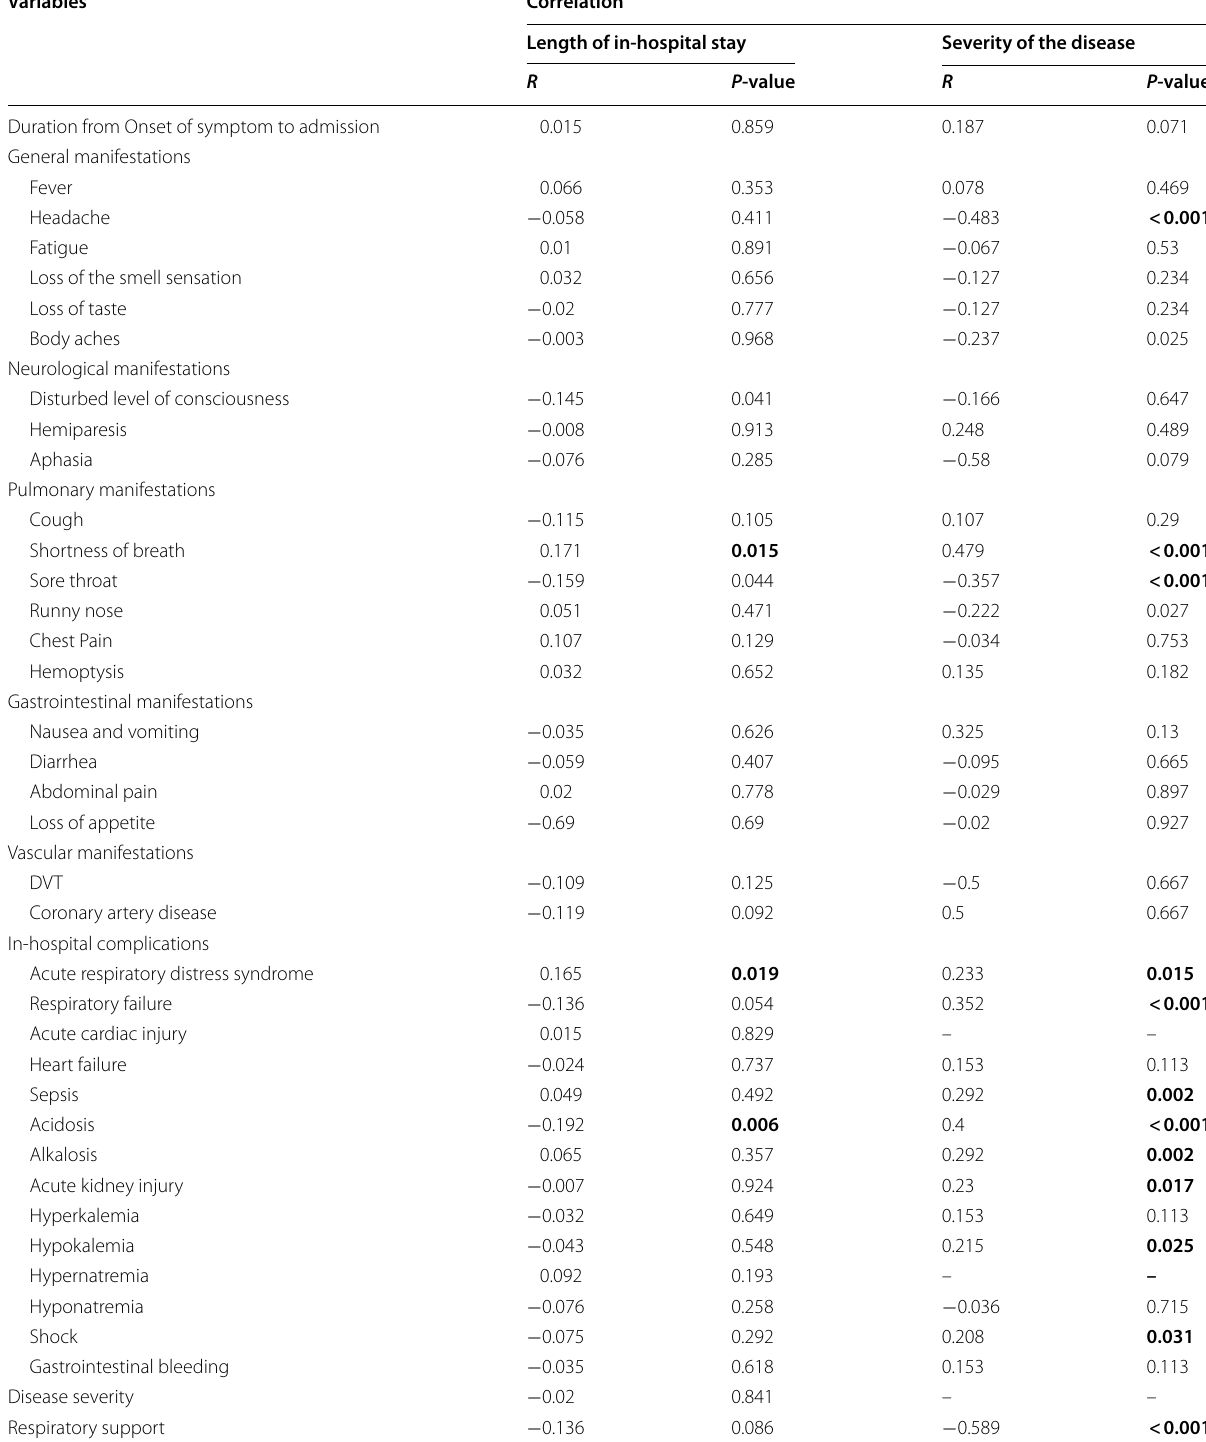
Bold values mean these varibles were statistically significant